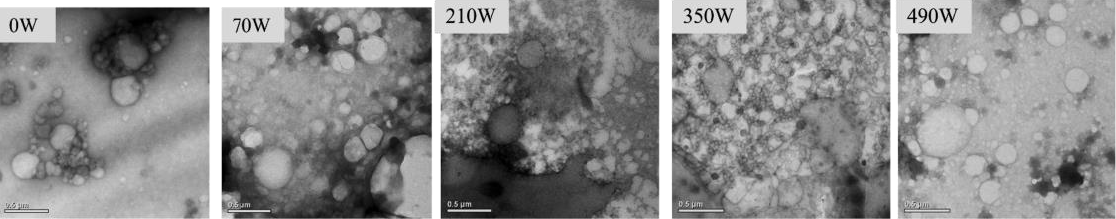
Figure 6. TEM of the lysozyme-oregano essential oil (LZ-OEO) bacteriostatic gels at different microwave power treatments .